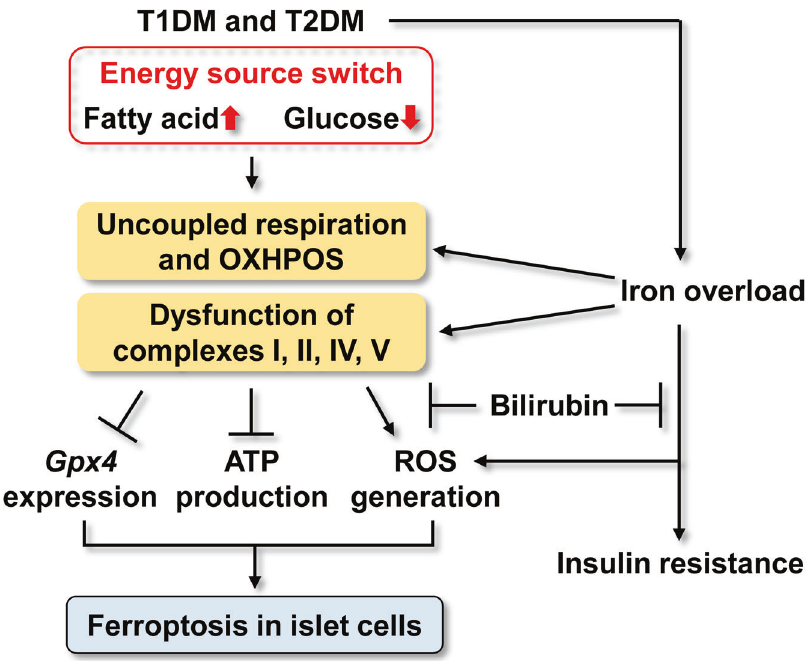
Fig. 6 The mechanisms underlying ferroptosis induction in diabetes. In diabetes mellitus, a switch of energy source (from glucose to fatty acids) occurs, leading to uncoupling of OXPHOS, and impaired function of ETC complexes. Consequently, Gpx expression and ATP production are both inhibited, while ROS generation is increased. These events ultimately induce ferroptosis in the islet cells. In addition to directly promoting ROS generation and insulin resistance, iron overload in diabetes mellitus can promote uncoupling of OXPHOS and dysfunction of the components of the